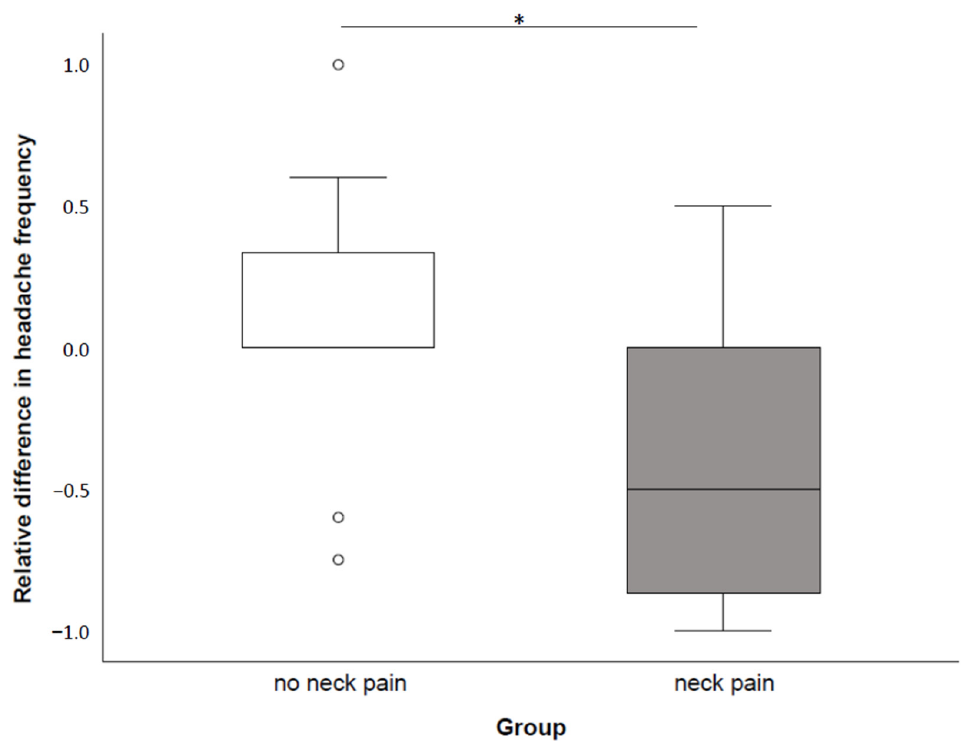
Figure 3. Relative difference in headache frequency (days/month) from baseline to follow up after rNMS intervention in patients with and without neck pain. Significant differences at α = 0.05 are marked with an asterisk (*). Table 4. Classification in responder rates based on the relative headache frequency reduction from pre-assessment to FU for the headache diagnosis, neck pain, and treatment time frame group comparisons.